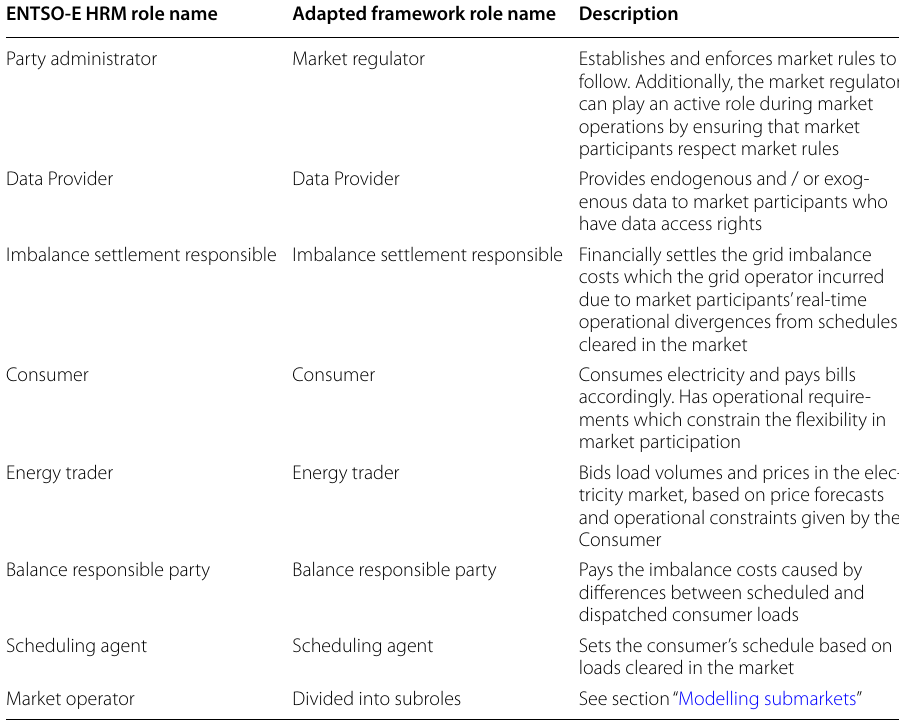
Table 2 Roles in electricity market MVE ENTSO-E HRM role